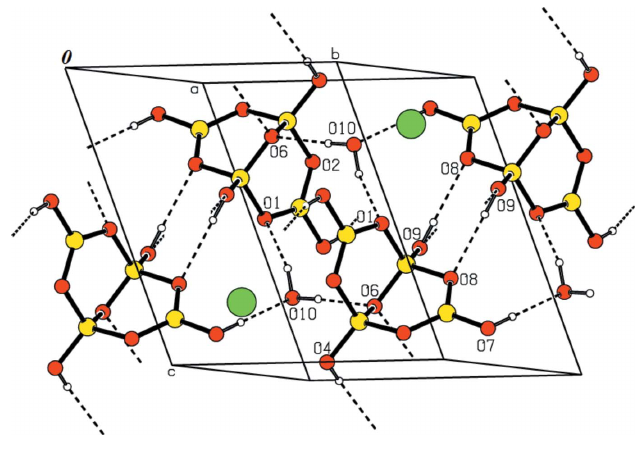
Figure 2 The crystal packing of the title compound, stabilized by medium–strong O—H (cid:2)(cid:2)(cid:2) O, O—H (cid:2)(cid:2)(cid:2) O water and O water —H (cid:2)(cid:2)(cid:2) O hydrogen bonds (shown as dashed lines; see Table 1 for numerical details).